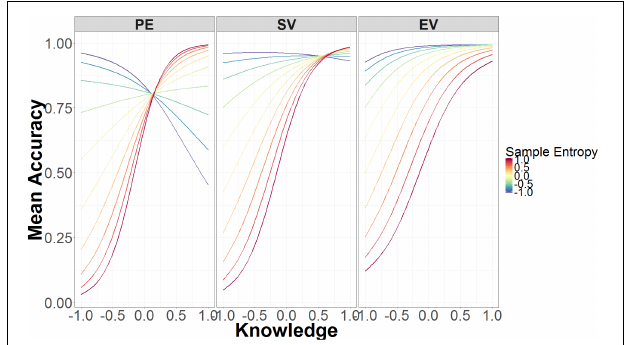
FIGURE 5 | Mean accuracy as a function of SE, security knowledge, and authentication level. The data on the x-axis are normalized and range from 2 SD below the mean ( − 1.00) to 2 SD above the mean ( + 1.00).